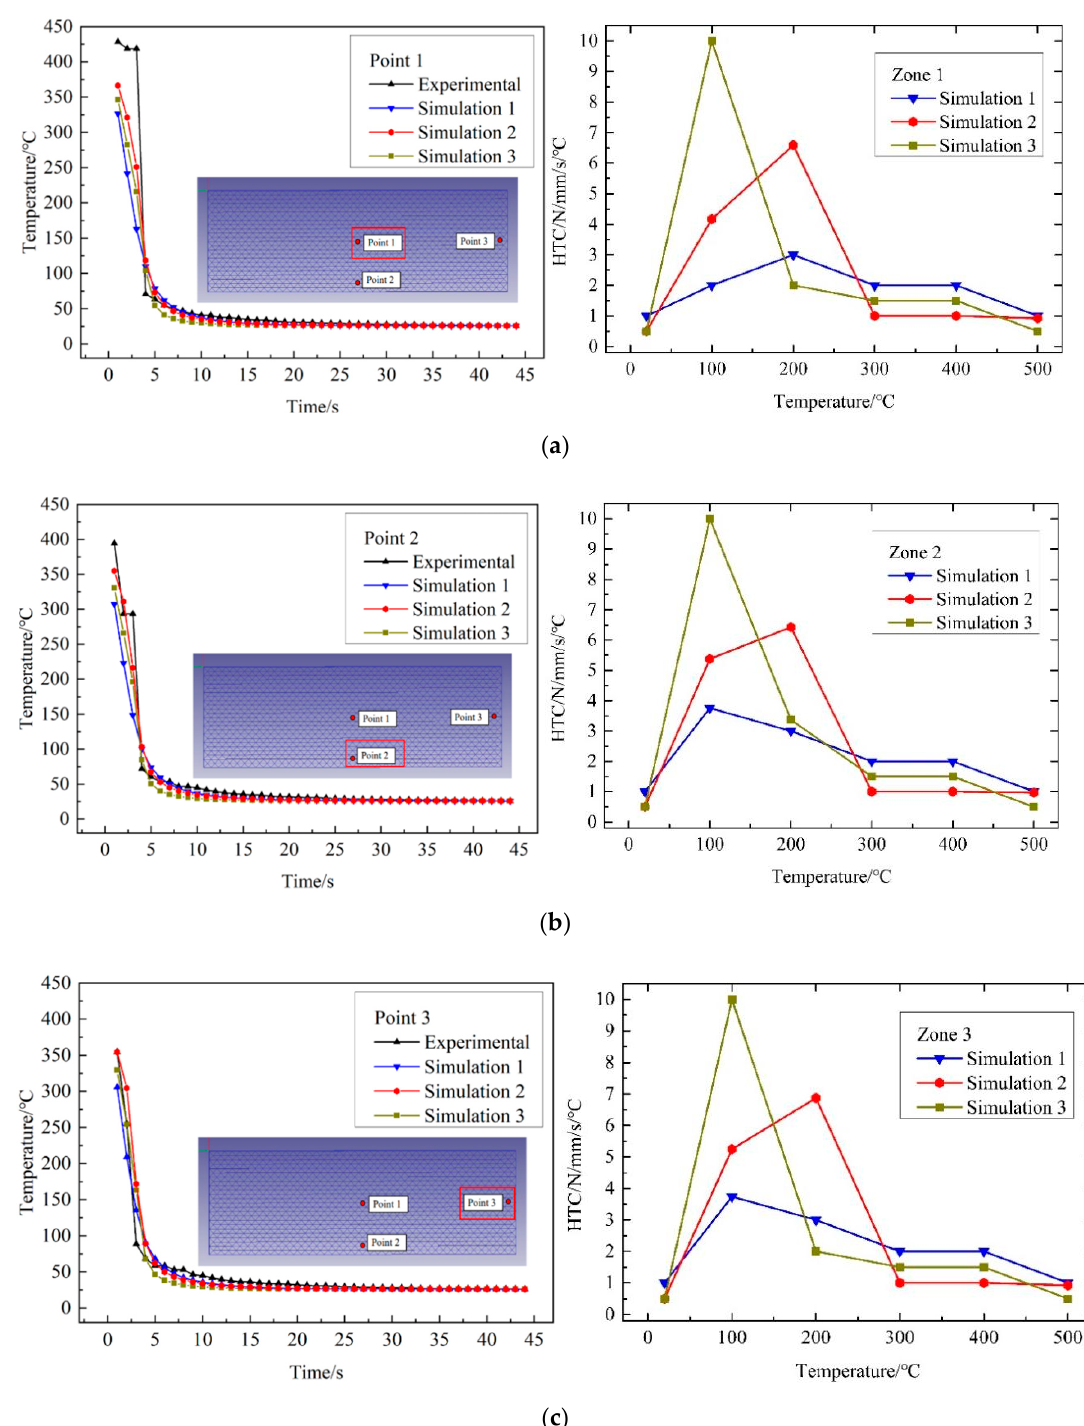
Figure 9. Temperature and heat transfer coefficient curves during quenching. ( a ) Comparison between the experimental temperature and the simulation temperature of point 1. ( b ) Comparison between the experimental temperature and the simulation temperature of point 2. ( c ) Comparison between the experimental temperature and the simulation temperature of point 3.